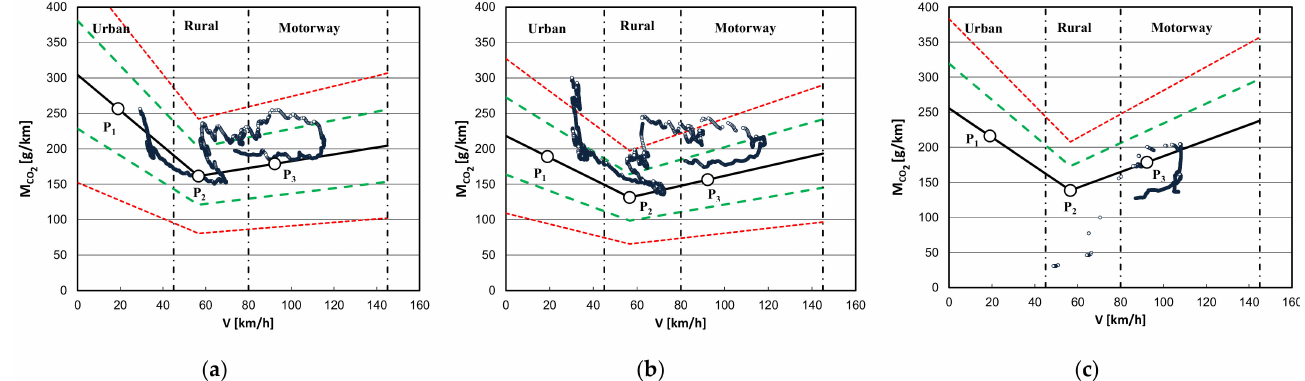
Figure 4. Characteristic curve of on-road carbon dioxide emission with the marked values of CO 2 emission in respective measuring windows, achieved in road tests in a passenger vehicle with a gasoline engine ( a ), a diesel engine ( b ), and PHEV ( c ); legend: P 1 , P 2 , P 3 —WLTP CO 2 , green line— ± 25%, red line— ± 50%, solid line—mowing average window CO 2 .